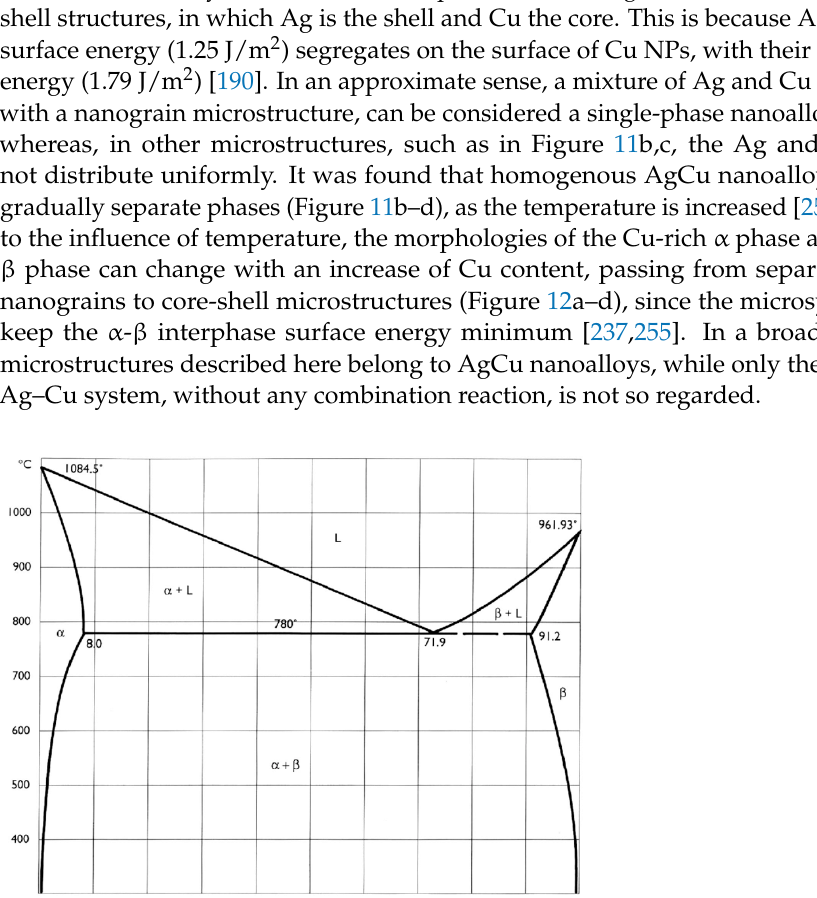
Figure 11. ( a ) Single-phase AgCu solid solution; ( b ) core-shell structure of AgCu nanoalloys; ( c ) structure of Ag and Cu in both phases; ( d ) biphasic. Reproduced with permission from Reference [254]. Copyright 2016, American Chemical Society. For AgCu nanoalloys with nanograin microstructures, Ag atoms are doped into the grain boundaries of the Cu matrix, and vice versa. In the case of a doped Cu matrix [256], a hybrid Monte Carlo/molecular dynamics simulation showed that Ag atoms segregated in the grain boundaries between Cu crystals. Ag atoms gradually aggregated along grain boundaries as the Ag concentration was increased (Figure 13a,b). After exceeding the threshold (50 atoms/nm 2 ), Ag atoms formed wetting nanolayers along the grain bounda- ries (Figure 13c–e). The reason is that these wetting nanolayers have lower energies [256]. In a similar fashion, when Cu atoms dope Ag, hybrid Monte Carlo/molecular dynamics simulations indicated that they segregated in grain or twin boundaries (Figure 14) [257].